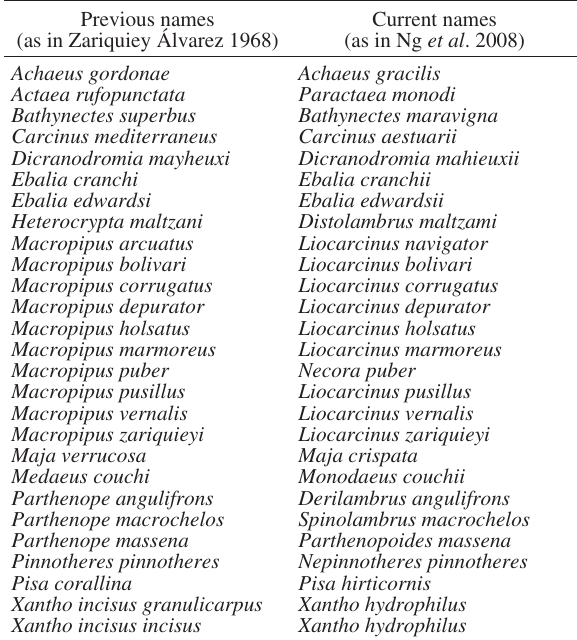
Table 2. – Previous and current names of brachyuran species present in the Iberian Peninsula renamed since Zariquiey Álvarez (1968), listed by alphabetical